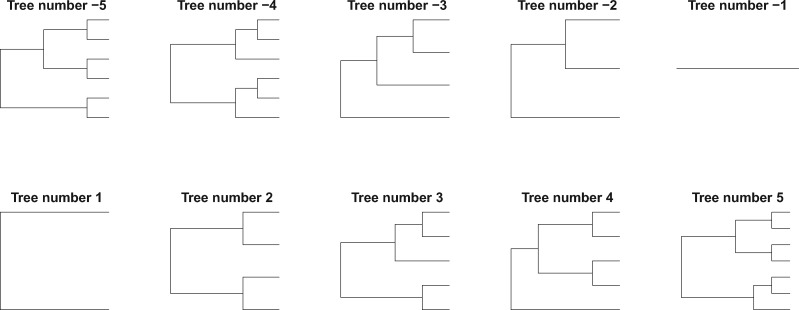
Some trees and their associated integers using the map \documentclass[12pt]{minimal}
\usepackage{amsmath}
\usepackage{wasysym}
\usepackage{amsfonts}
\usepackage{amssymb}
\usepackage{amsbsy}
\usepackage{upgreek}
\usepackage{mathrsfs}
\setlength{\oddsidemargin}{-69pt}
\begin{document}
}{}$\psi_\mathbb{Z}$\end{document} of Example 1. The numbering goes from \documentclass[12pt]{minimal}
\usepackage{amsmath}
\usepackage{wasysym}
\usepackage{amsfonts}
\usepackage{amssymb}
\usepackage{amsbsy}
\usepackage{upgreek}
\usepackage{mathrsfs}
\setlength{\oddsidemargin}{-69pt}
\begin{document}
}{}$-$\end{document}5 to 5, with the exception of 0 which corresponds to the “empty tree”.